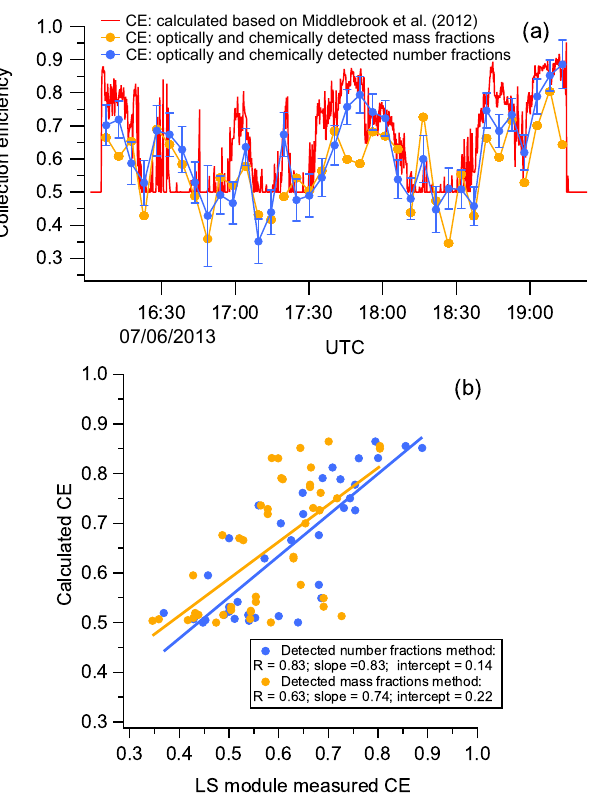
Figure 9. (a) Time series plot of AMS collection efficiency calcu- lated based on aerosol chemical composition and relative humidity method described in Middlebrook et al. (2012) (red) and measured by AMS LSSP mode based on number (blue) or mass (yellow) ra- tio of optically and chemically detected particles to total optically detected particles of 6 July 2013 flight. (b) Scatter plot of the pa- rameterized, composition-dependent CE vs. the LS module mea- sured CE based on optically and chemically detected particle num- ber fractions (blue, correlation coefficient R = 0 . 82) and mass frac- tions (yellow, correlation coefficient R = 0 . 64) for the 6 July 2013